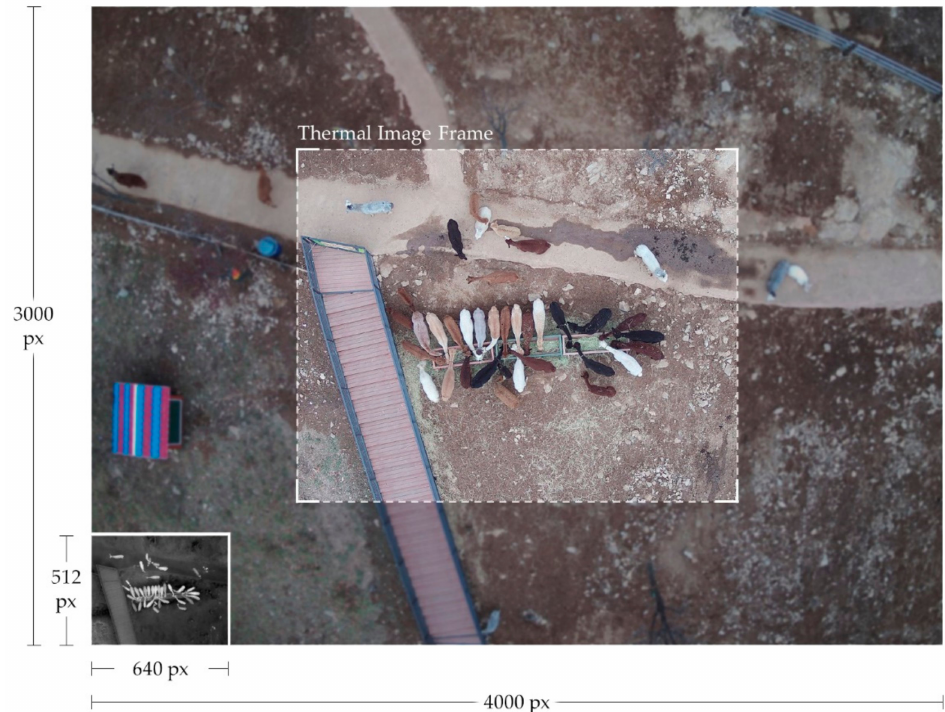
Figure 3. Representative outputs from the thermal sensor. The small image at the bottom-left is the thermal image (640 × 512 px), and the larger image is the RGB image (4000 × 3000 px). The coverage area of the thermal im- age is marked by the white rectangle in the RGB